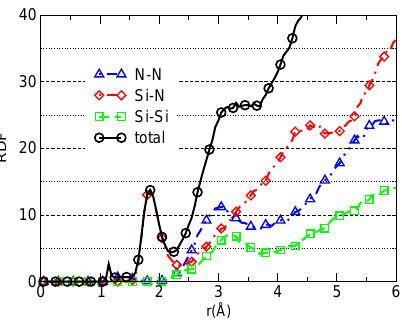
Fig. 4. Radial distribution function for the liquid Si 3 N